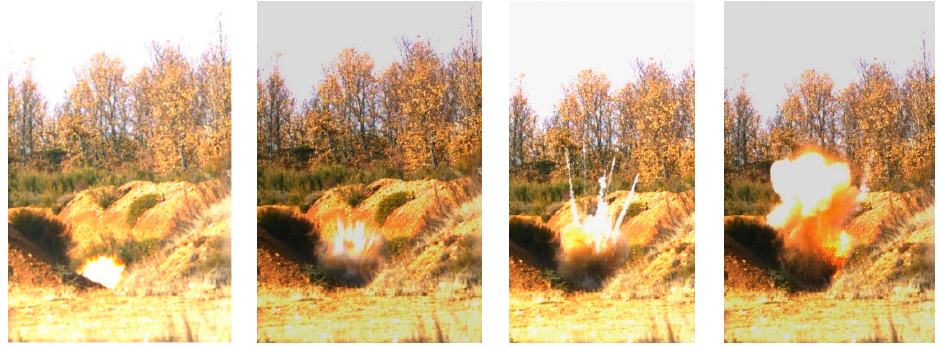
Figure 7. Detonation sequence of bulk TATP recorded with a high-speed camera at the INTA test site near Leon, Spain.